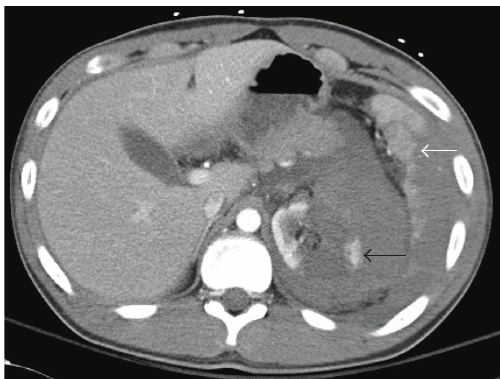
Figure 1: Axial CT of the abdomen revealing extensive left renal hematoma and laceration (white arrow). Also note the splenic laceration with subcapsular hematoma (black arrow).